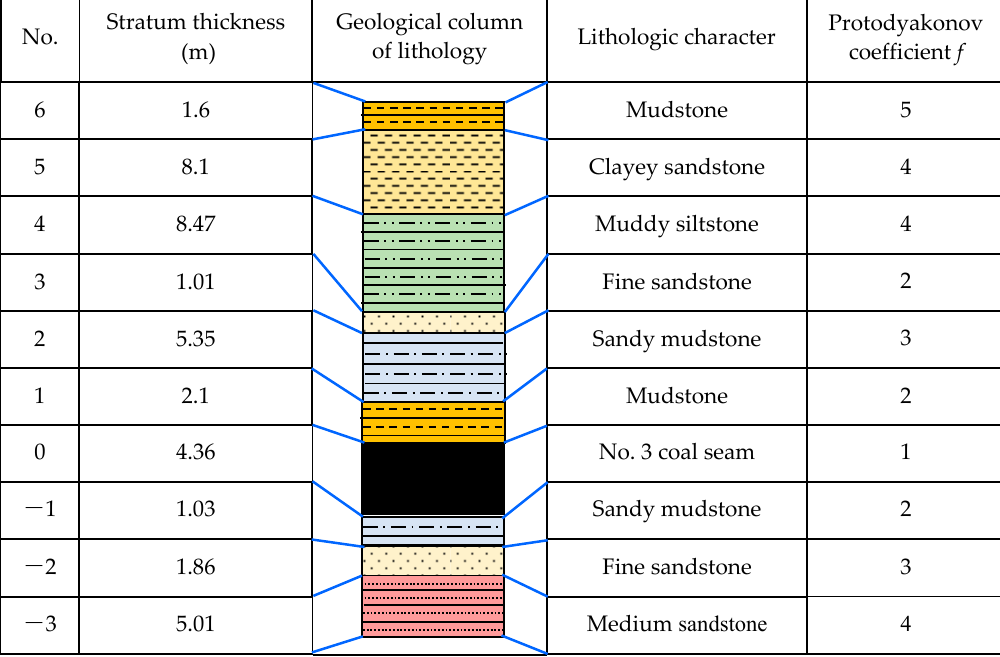
Figure 1. The comprehensive histogram of No. 3 coal seam and rock strata.